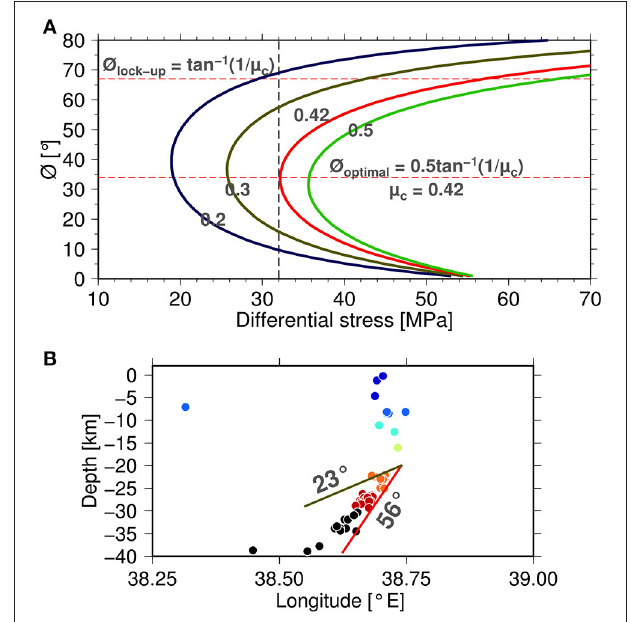
FIGURE 8 | (A) Dip (90- φ ) of reactivated fault in the lower crust for pore fluid factor of 0.95 for different friction coefficients. (B) Depth distribution of earthquakes projected on E-W line, along the dip direction of rift parallel faults. The linear seismicity streak in the lower crust is bounded by an optimal (56 ◦ ) and lock-up (23 ◦ ) dip angles for friction coefficient of